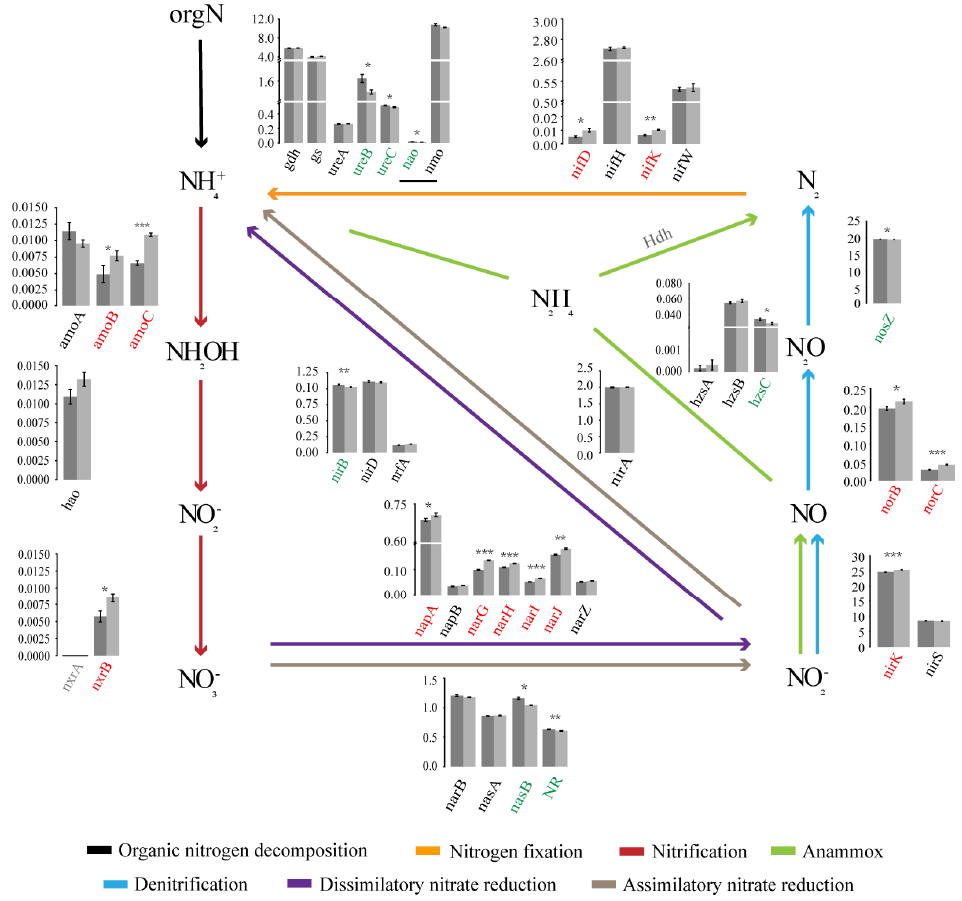
Figure 6. The schema characterizes soil microbial N cycling network. The histogram denotes the differences of the relative abundance of functional genes involved in N cycling pathways between the two different forest types. Dark grey and light grey represent the PF and SF, respectively. The gene families on the abscissa are marked in different colours. Red indicates that the gene is significantly enriched in SF. Green indicates that the gene is significantly enriched in PF. The values on the ordinate represent the percentage abundance of functional genes in total N cycling genes (%). Different colours of lines represent different N cycling processes. PF: Primary Korean pine forests, SF: Secondary broad ‐ leaved forests. p < 0.05 *, p < 0.01 **, p < 0.001 ***.